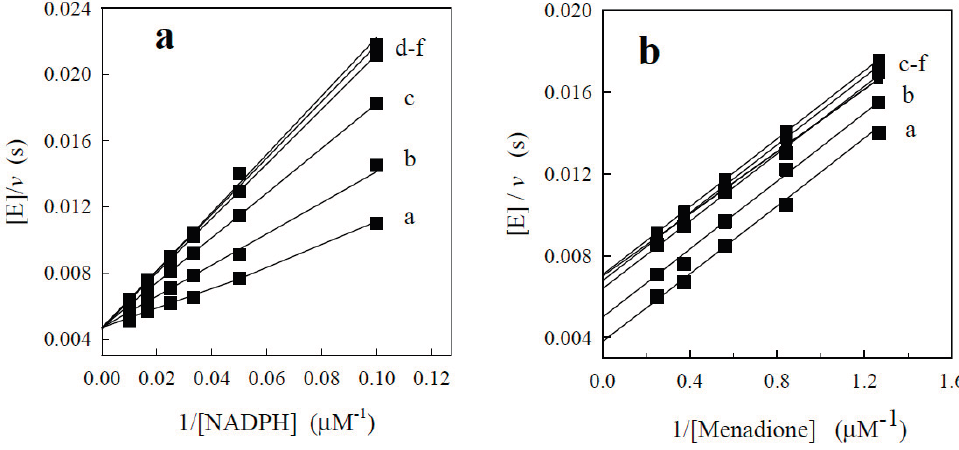
Figure 6. The inhibition of NQO1 by benzofuroxan with respect to the quinone reductase reaction of NQO1 ( a ) The dependence of the enzymatic rate on concentrations of NADPH at fixed concentration of menadione (4 µM) and fixed concentrations of benzofuroxan: 0 µM (a), 25 µM (b), 50 µM (c), 100 µM (d), 200 µM (e), and 300 µM (f); ( b ) The dependence of the enzymatic rate on varied concentrations of menadione at fixed concentration of NADPH (40